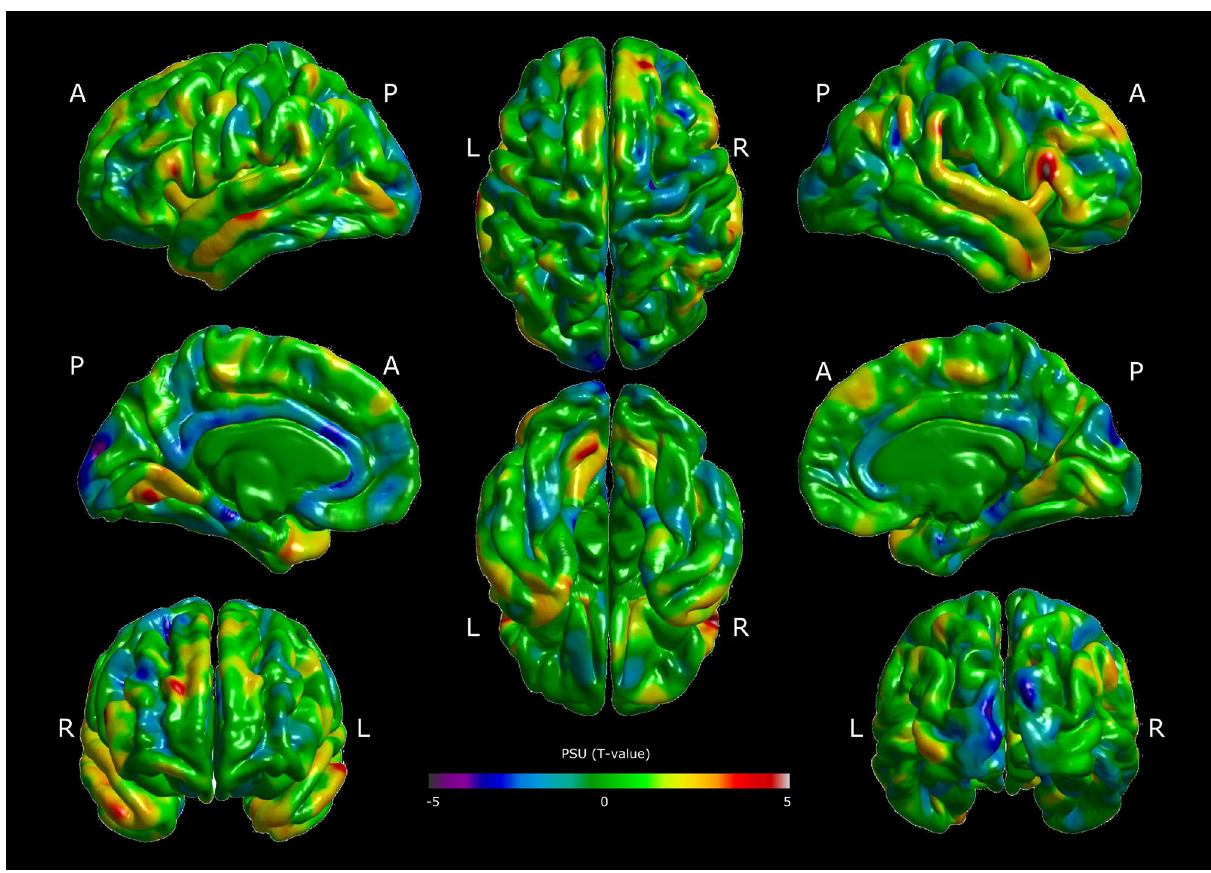
Figure 2. Cortical thickness results and their correlation with the University Selection Test outcomes (PSU) (language + mathematics), corrected by sex and socioeconomic status. Colors represent the T-Value per vertex. A: anterior; P: posterior, R: right, L: